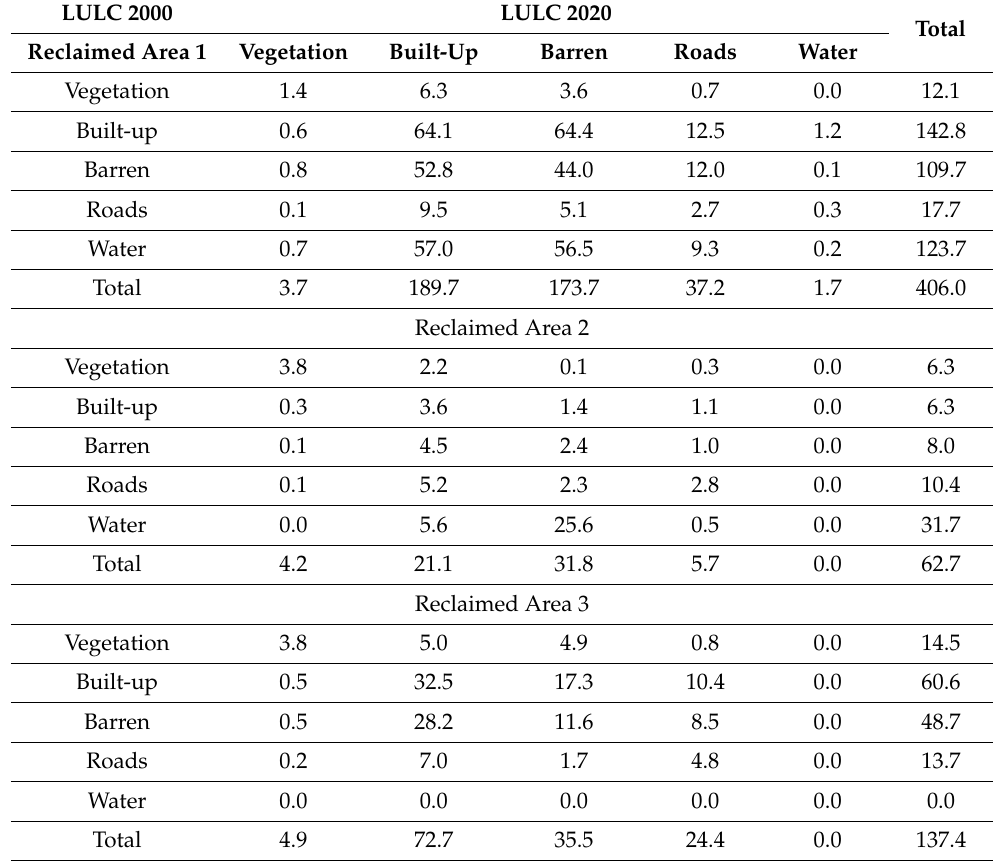
Table 5. Transition matrix of LULC from 2000 to 2020 within Dammam reclaimed coastal regions in